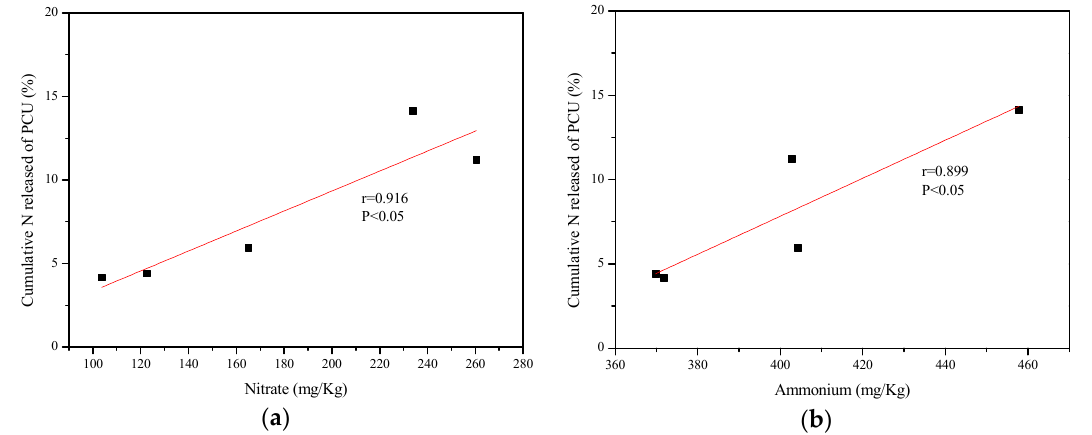
Figure 4. Correlation between cumulative nitrogen release rate of PCU and ( a ) nitrate and ( b ) ammonium in soil.